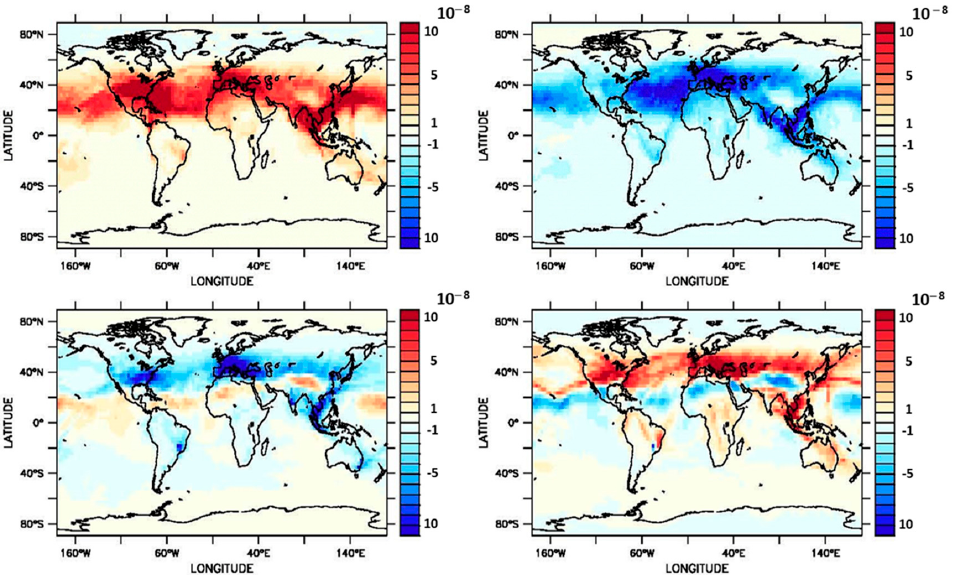
Figure 3. Change in net ozone production [10 − 12 mol/s] Flying Higher ( left ) and Flying Lower ( right ) compared to reference case in autumn at 200 hPa (upper row) and 300 hPa (lower row).